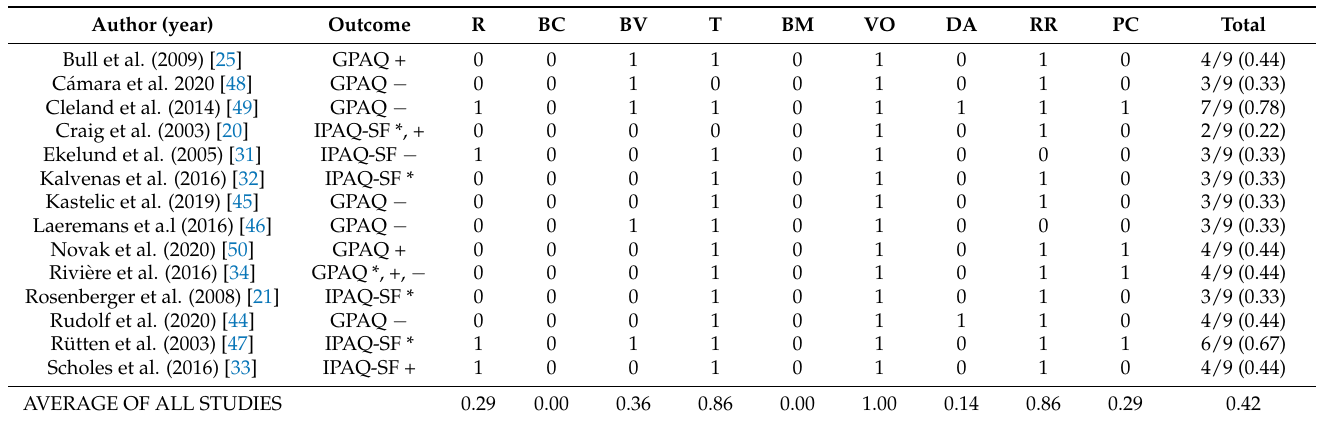
Table 6. Results of the risk-of-bias